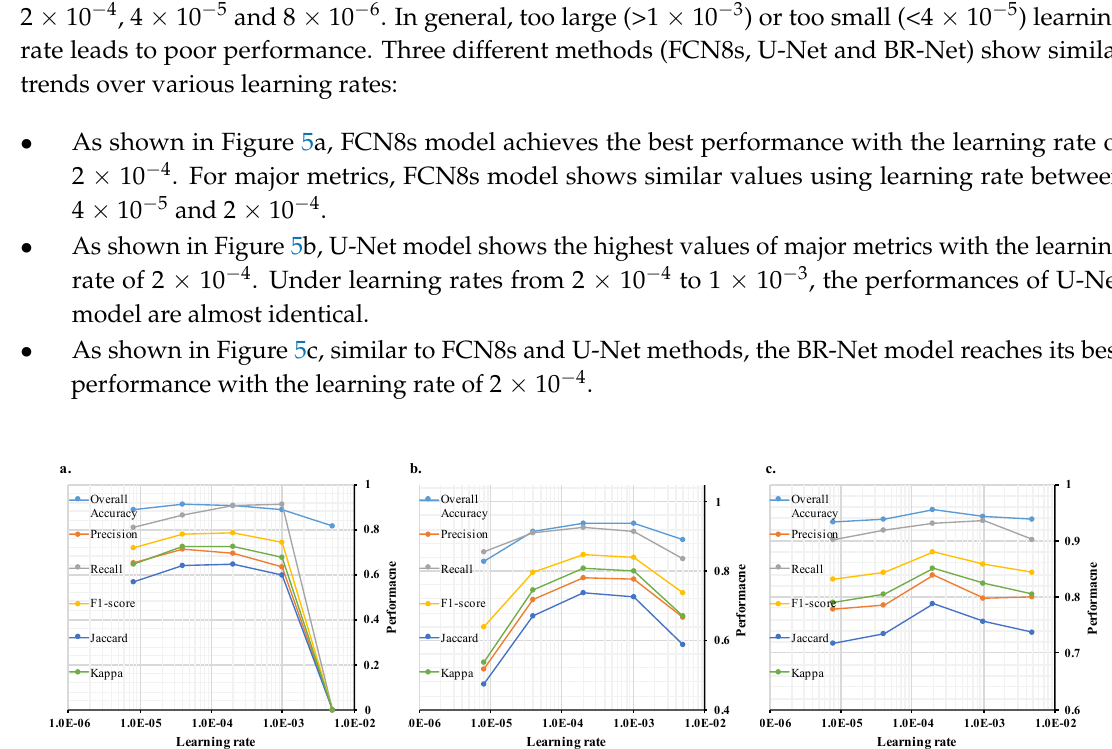
Figure 5. Model performances using learning rates of 5 × 10 − 3 , 1 × 10 − 3 , 2 × 10 − 4 , 4 × 10 − 5 and 8 × 10 − 6 : ( a ) performances of FCN8s under various learning rates; ( b ) performances of U-Net under various learning rates; and ( c ) performances of BR-Net under various learning